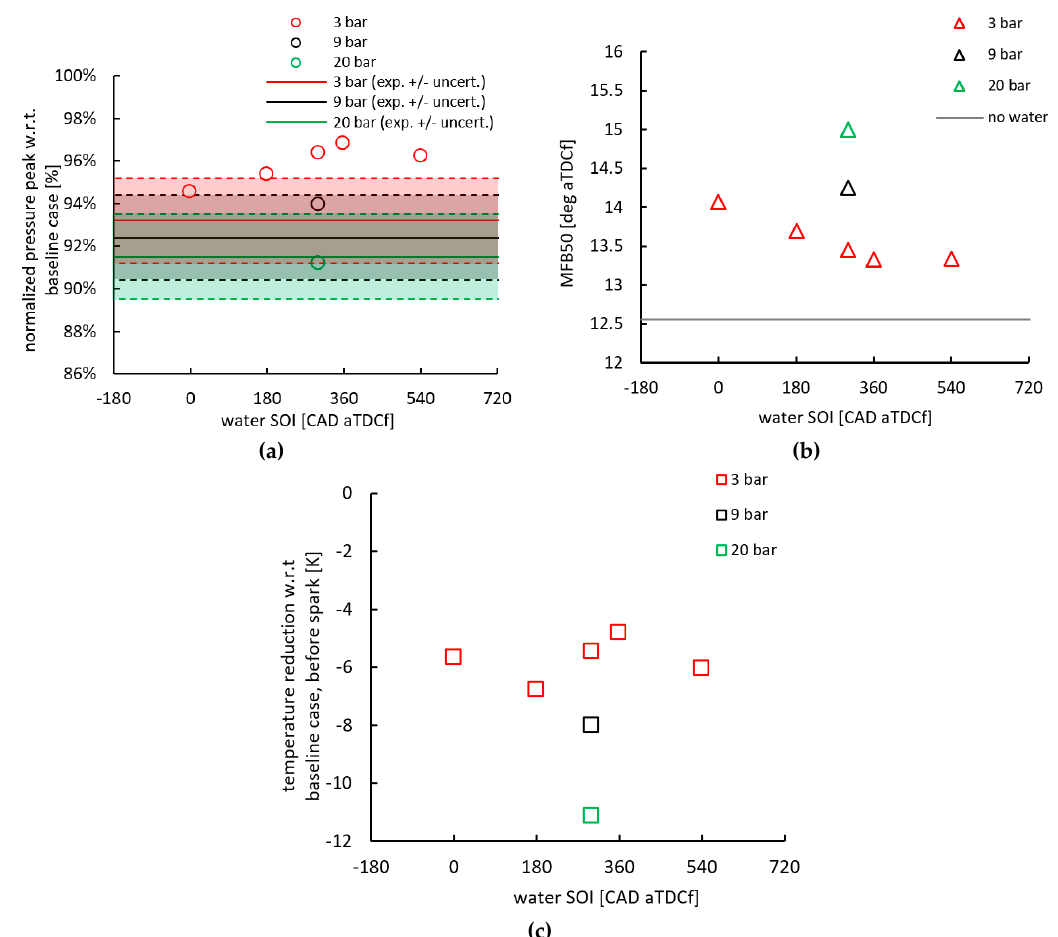
Figure 12. Water effect on ( a ) pressure peak; ( b ) combustion phasing; and ( c ) charge cooling before spark, at − 20 CAD aTDCf. Spark timing is fixed at SA = − 14 CAD aTDCf.